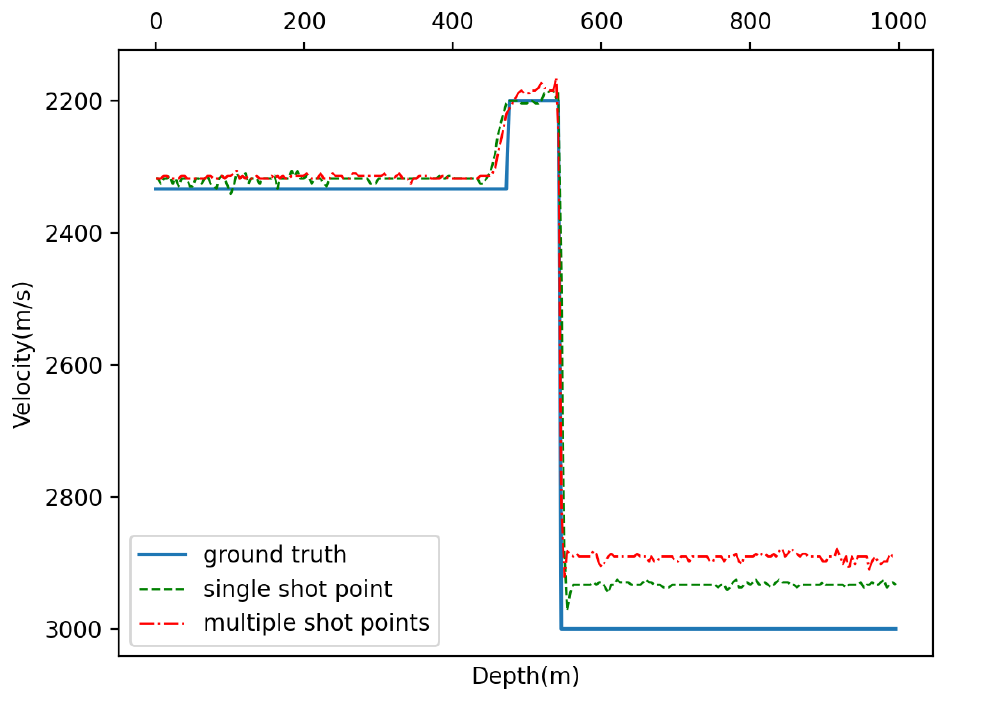
Figure 13. Prediction for velocity field and anomaly with 2 anomalies and no fault.